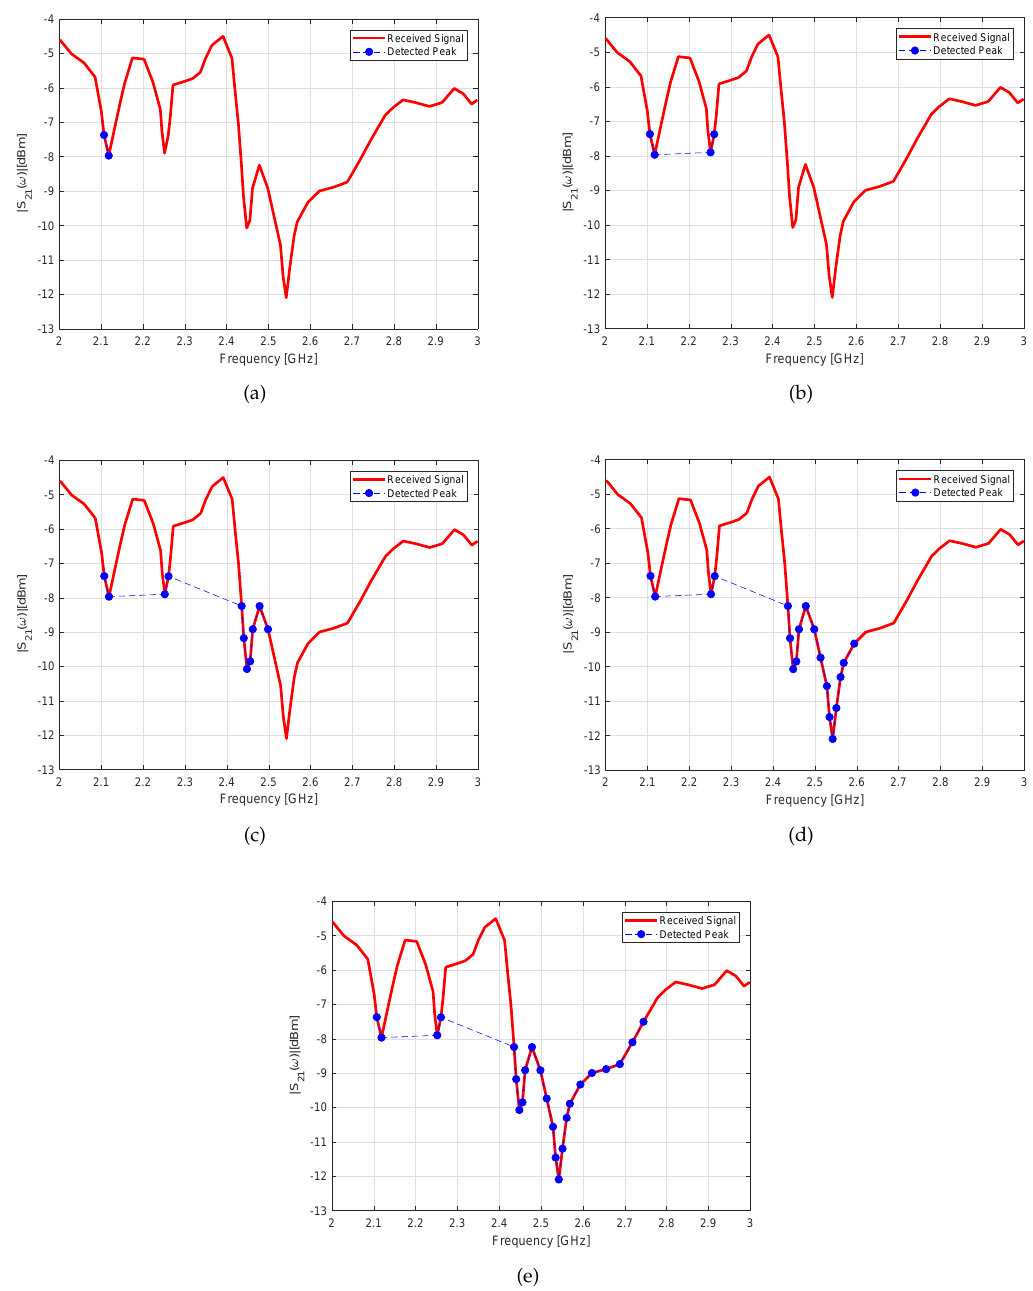
Figure 11. Peak detection for the received real-time signal with the tag configuration of 11110 using the newly proposed method. ( a ) step 1, ( b ) step 2, ( c ) step 3,( d ) step 4, and ( e ) final